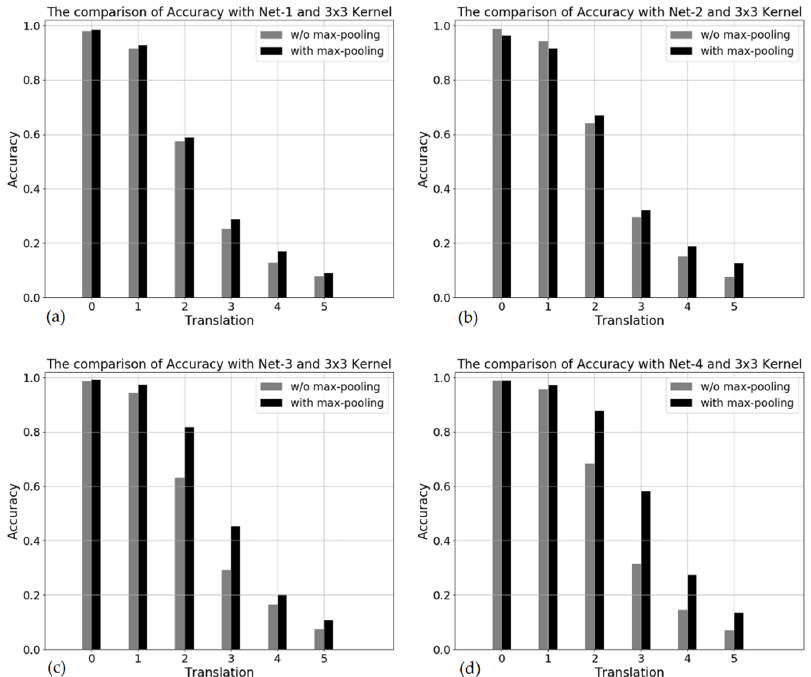
Figure 7. The comparison of networks with and without max-pooling by varying network depth with the same 3 × 3 kernel size. ( a – d ) for the Net-1, Net-2, Net-3 and Net-4 networks, respectively.